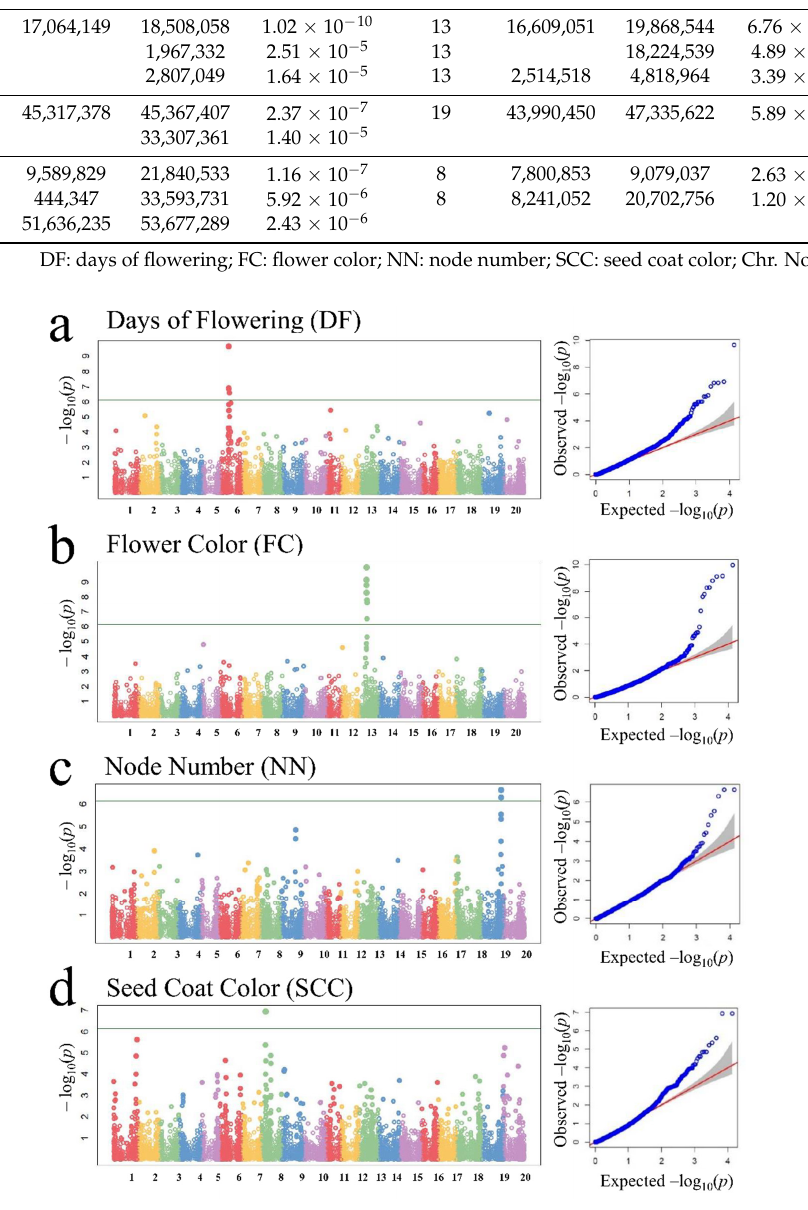
Figure 2. Manhattan and quantile–quantile plots generated by GAPIT to identify significant associ- ations between SNP markers and phenotypic traits; ( a ): days of flowering (DF); ( b ): flower color (FC); ( c ): node number (NN); ( d ): seed coat color (SCC). 2.4. Candidate Genes for Four Traits (DF, FC, NN, and SCC) To identify candidate genes for DF, FC, NN, and SCC, the genes that were highly associated with SNPs (Table 2) were analyzed using the GBS data for the 192 soybean MDP lines (Table 3). A total of 39 genes revealed by GWAS were identified on chromo- somes 1, 2, 6, 7, 8, 9, 11, 12, 13, 15, 19, and 20. For DF, 17 SNPs were located in 14 genes, of which 6 genes comprising 7 SNPs were on chromosome 6. The remaining 8 genes with 2, 1, 1, 1, 1, 3, and 1 SNPs were on chromosomes 2, 7, 11, 13, 15, 19, and 20, respectively. The 6 DF-related genes with 7 SNPs on chromosome 6 were identified as Glyma.06g198100 , Glyma.06g204600 , Glyma.06g205600 ( RGP3 and RGP ), Glyma.06g205900 ( GAUT11 ), Glyma.06g208300 ( TET11 ), and Glyma.06g211600 . All of the SNPs were located in genic regions, including four and three nonsynonymous and synonymous SNPs, respectively. The locus most highly associated with DF, Chr06_19,461,588 ( p = 2.20 × 10 − 10 , R 2 = 0.531) in Glyma.06g205600 , was revealed to contain a nonsynonymous SNP. Specifically, compared with the wild-type sequence, T was replaced by C, which resulted in an amino acid change from Val (GUA) to Ala (GCA). For FC, the 13 detected SNPs were located in 13 different genes, of which the following 12 were on chromosome 13: Glyma.13g070400 ,